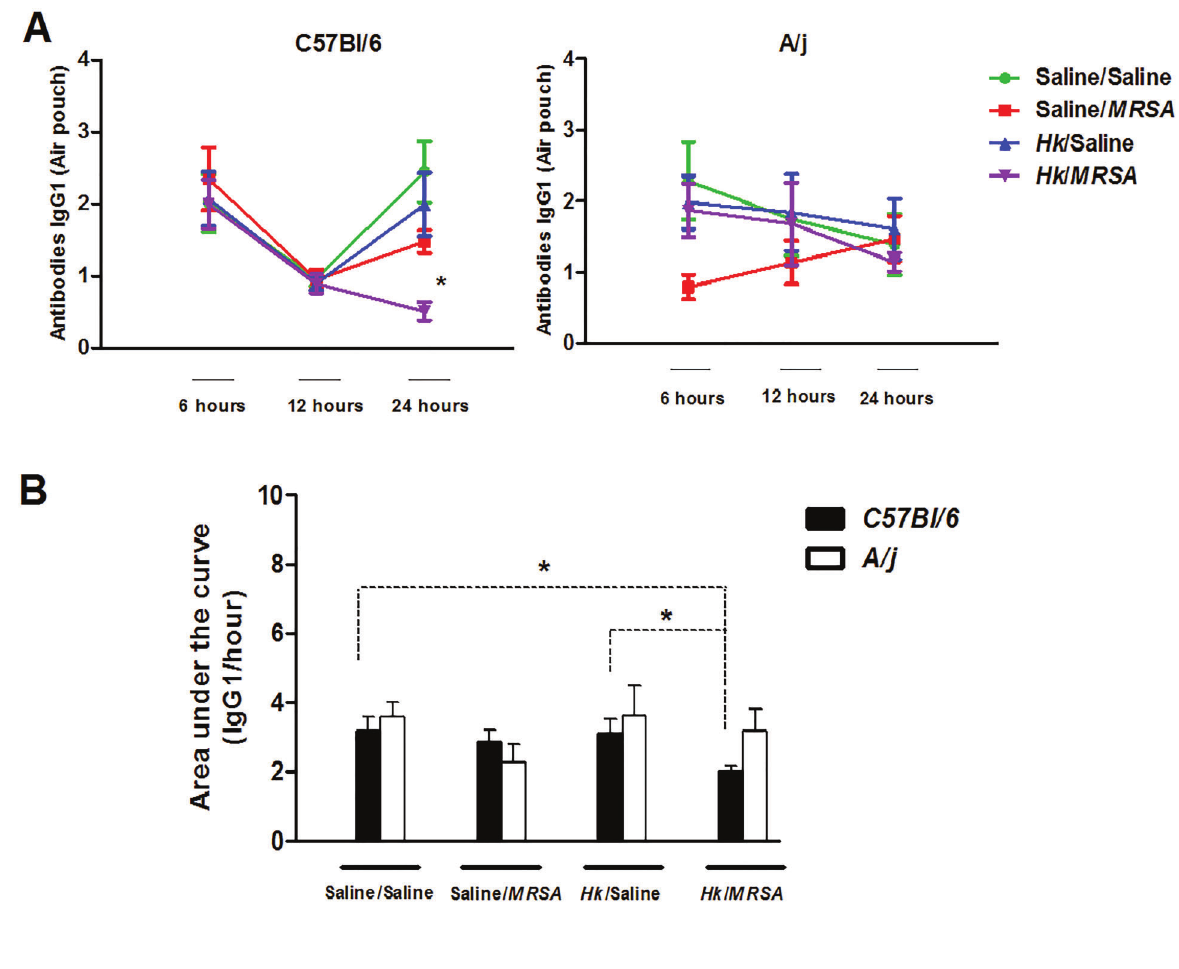
Figure 3. C57BL/6 and A/j mice previously immunized with 10 6 strains of MRSA inactivated by heat were challenged in the air pouch with 10 7 colony forming units (CFU) live MRSA. A , Concentration of IgG1 in air pouch sample from both lineages. B , Comparison of antibody concentrations in the two lineages. Data are reported as means ± SD (n=6). MRSA: methicillin-resistant Staphylococcus aureus ; Hk: Heat killed. *P o 0.05 ( A , Kruskal-Wallis test and Dunn ’ s post-test; B , Mann-Whitney